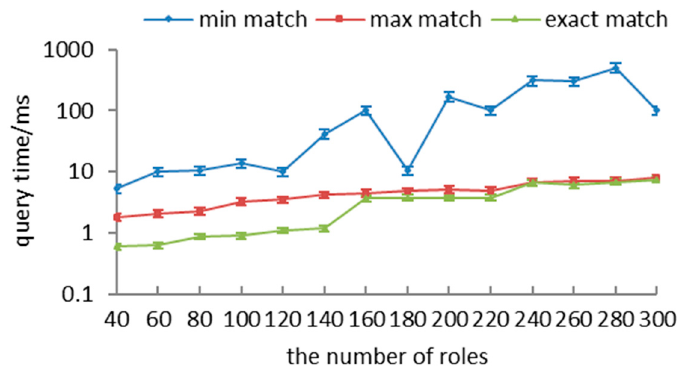
Figure 1. Comparison of the different scenarios.